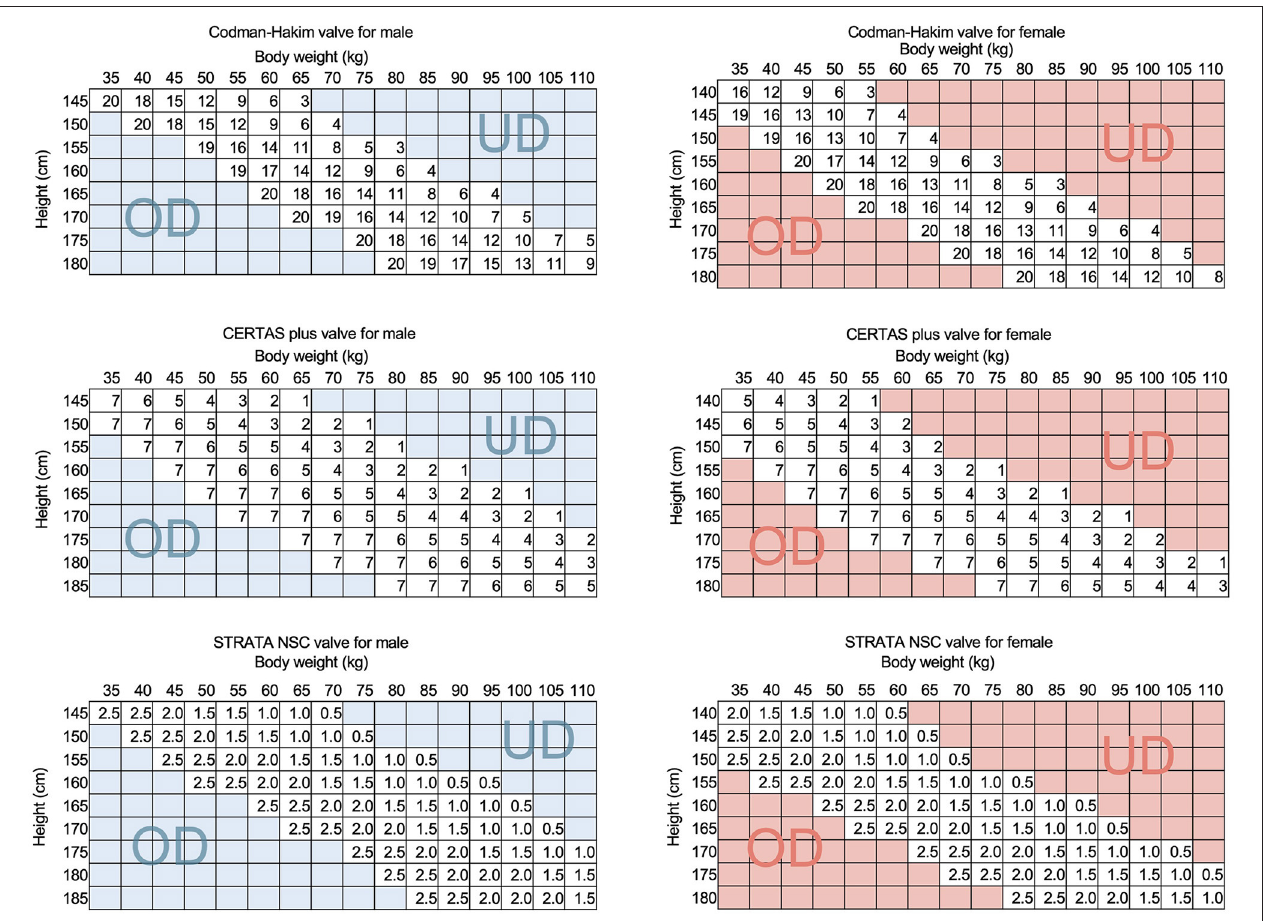
FIGURE 1 | The QRTs of representative programmable valves. The QRTs for CH valve, CERTAS plus valve, and STRATA NSC valve are shown for men and women. The SINPHONI study proved the validity of the initial pressure setting method by QRT by showing a low valve readjustment rate of 44%. This QRT simulates that if a patient’s weight increases by 5kg, the optimal settings of the CH and CERTAS plus valves will be reduced by about 30mm H 2 O and 1, respectively. This simulation suggests that a weight change of 5kg is a risk for shunt malfunction. The UD and OD in the figure indicate that patients in this region are at higher risk for underdrainage and overdrainage, respectively. UD, underdrainage; OD,